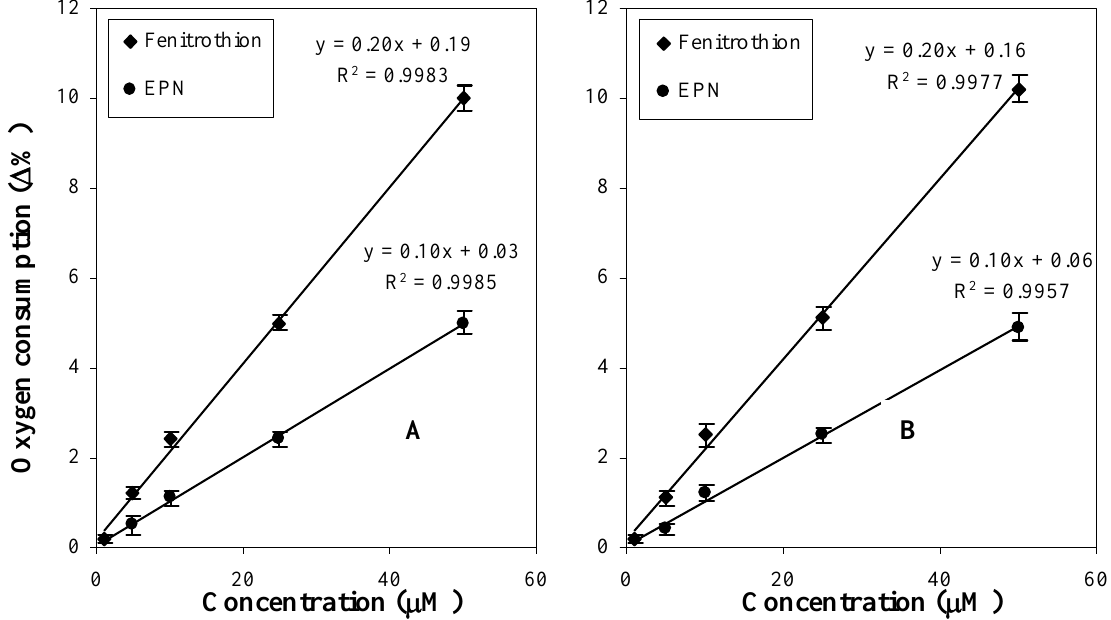
Figure 1. Calibration plots for fenitrothion and EPN. A) in 50 mM pH 7.5 citrate-phosphate buffer with 50 µ M CoCl and B) in Lake Elsinore water filtered and adjusted to pH 7.5 and 50 µ M CoCl 2 room temperature, with 0.086 mg cell loading. Data are given as mean ± 1 standard deviation for three